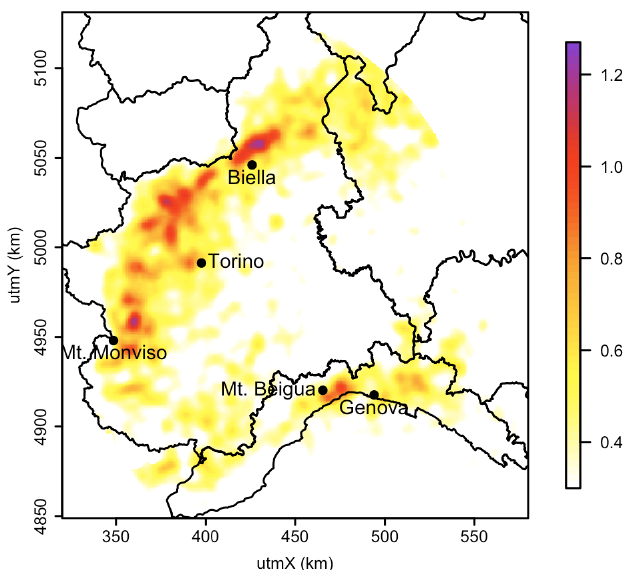
Figure 8. Oversampled spatial distribution of IDs density on the Northwestern Italy (IDs per square km). Redder areas indicate the presence of a greater number of IDs.